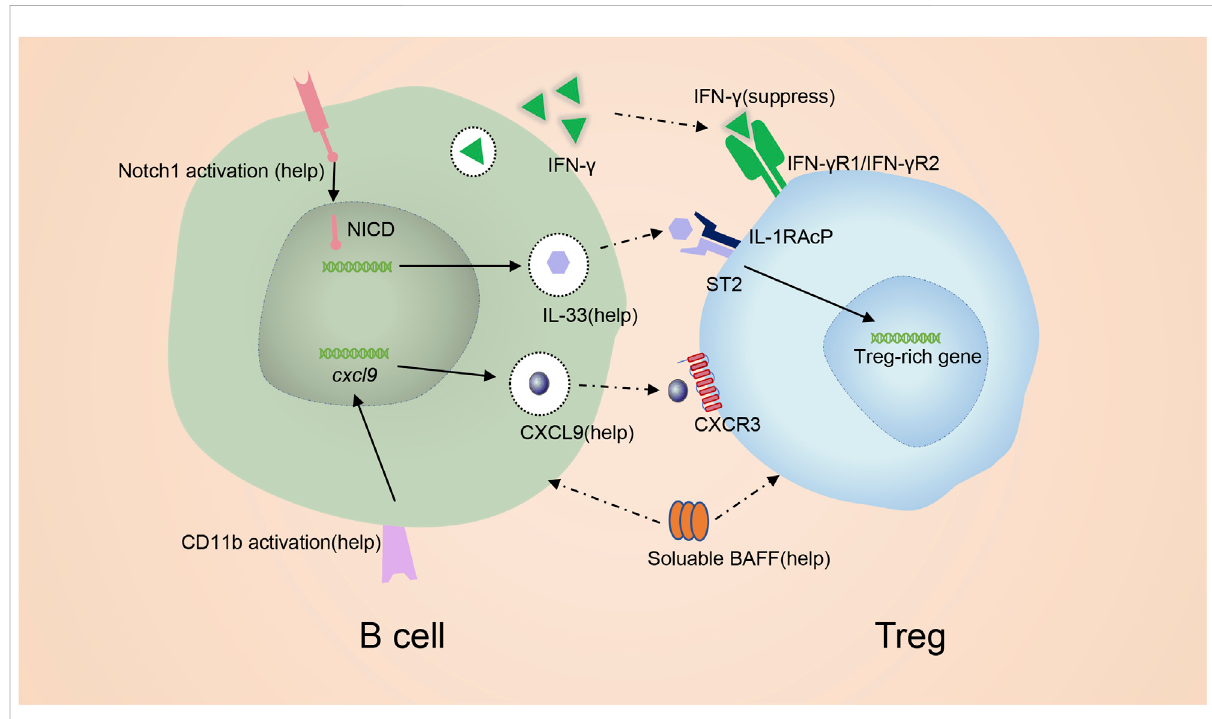
FIGURE 4 mechanismofpromotingTregbyBcells.IFN- γ fromBcellsinhibitsTregs.GITR-LonBcellsmaintainsTregsatasuf fi cientlevel.Notchsignaling inducestheexpressionofIL-33.IL-33bindingtoST2tofavortheproductionofTreg.CD11bsignalinBcellsinducetheproductionofCXCL9whichis capable of recruiting Tregs. BAFF can also promote